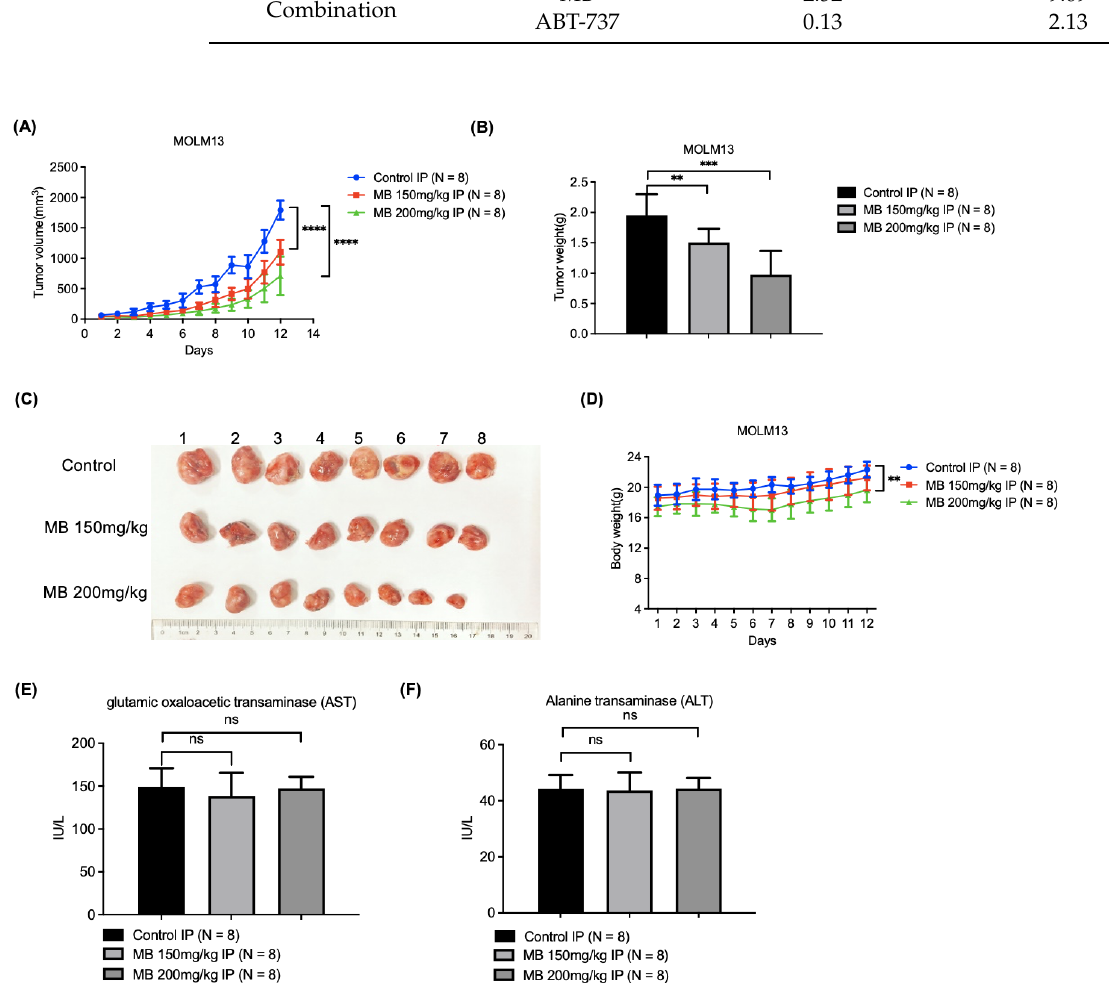
Figure 6. MB effectively inhibited the growth of AML cell xenografts in nude mice with relatively low toxicity. ( A , B ) The sizes and weights of tumour xenografts in nude mice from different treatment groups (N = 8). ( C ) Images of the tumour xenografts. ( D ) The body weights of mice in different groups. ( E , F ) Serum AST and ALT levels in each mouse from different groups. IP: Intraperitoneal injection. Error bars represent SD. ** p < 0.005, *** p < 0.0005 compared to the control group.